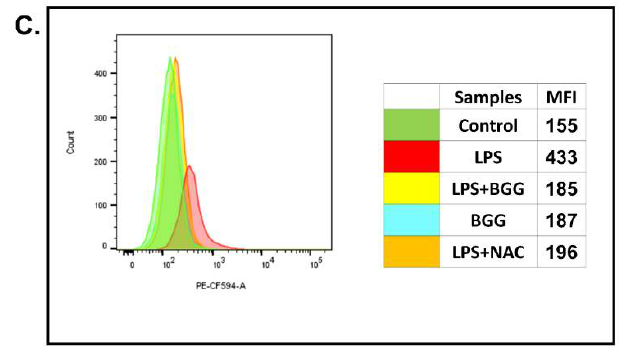
Figure 1. RAW 264.7 cells and mice peritoneal macrophages were pre-treated with BGG (10 μM) and NAC (10 μM) for 1 h, followed by LPS (1 μg/mL) stimulation for 23 h. BGG attenuates the LPS-induced ROS production in ( A ) RAW 264.7 and ( B ) in mice peritoneal macrophages, and ( C ) BGG protects LPS-induced superoxide production in RAW 264.7 macrophages, measured by MitoSox Red. Results are mentioned in mean fluorescence intensity.